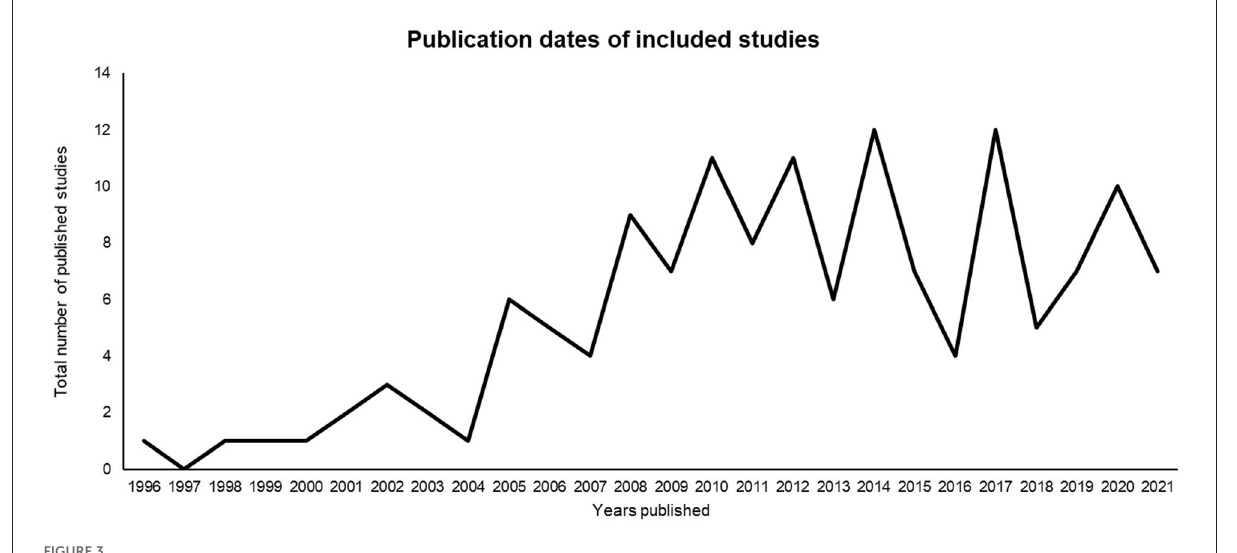
FIGURE3 Publication dates of included